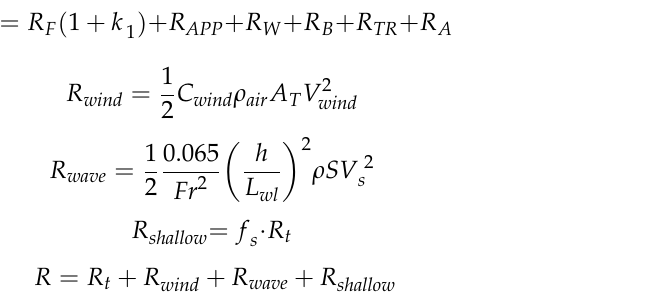
Figure 7. Schematic diagram of the route division based on the navigation environment.